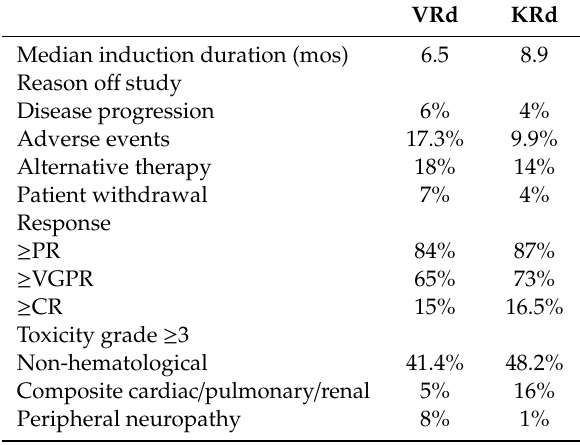
Table 1. Treatment, e ffi cacy, and safety data from the ENDURANCE (E1A11) trial.